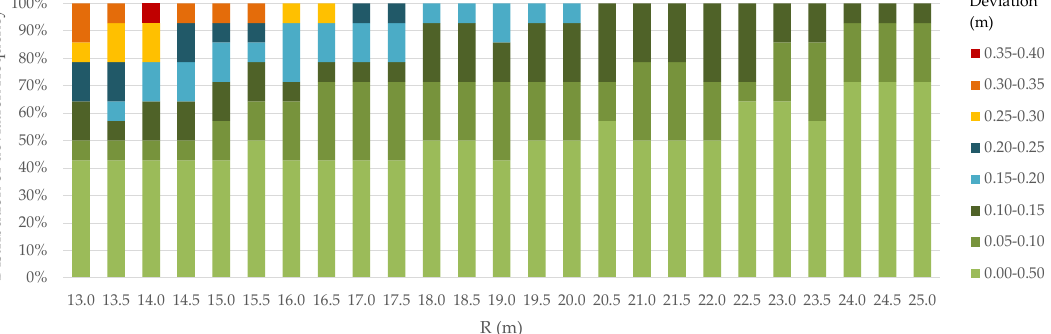
Figure 13. Distribution of deviation frequency for right-hand-side trajectories at cross-sections 4–10.